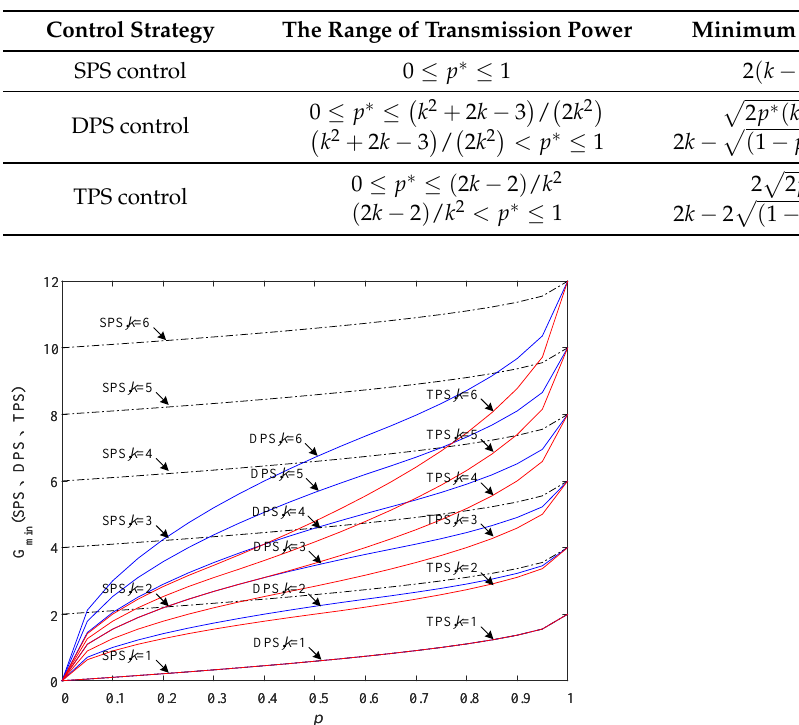
Figure 5. Comparison curves of current stress under different control